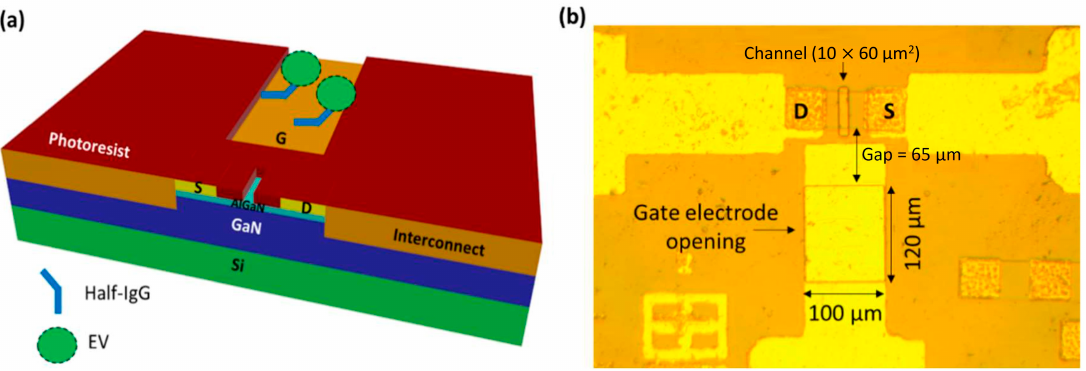
Figure 7. The schematics ( a ) side and ( b ) top view of EDL HEMT. Reprinted from reference [139]. Copyright 2018, with permission from Sensors and Materials.